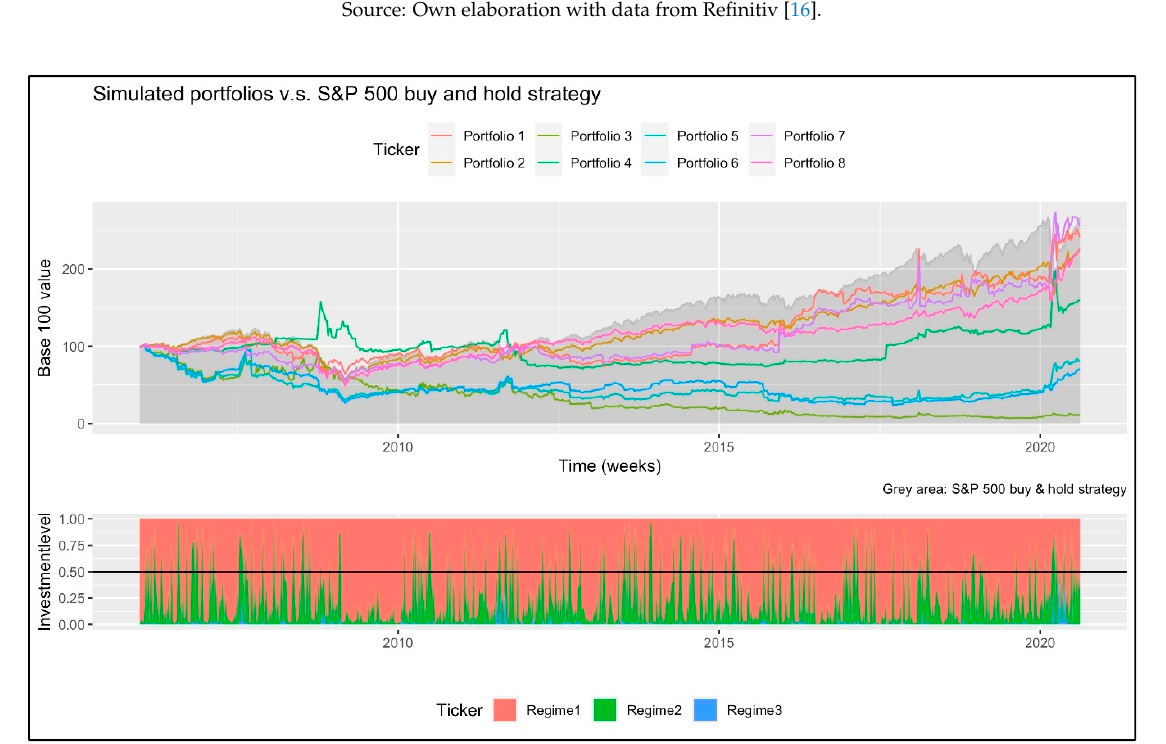
Figure 4. The historical performance of the 8 simulated portfolios of an individual investor that pays VIX future roll-over costs and 0.1% stock trading fees plus VAT. Source: Own elaboration with data from Refinitiv [16].